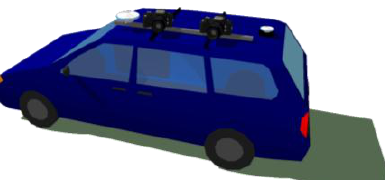
Figure 1. Scheme of the vehicle equipped with two cameras and two GPS antennas used for the kinematic tests